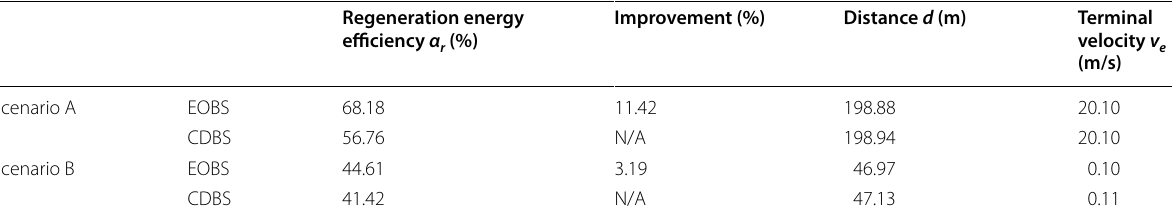
Table 3 Simulation results of EOBS and CDBS